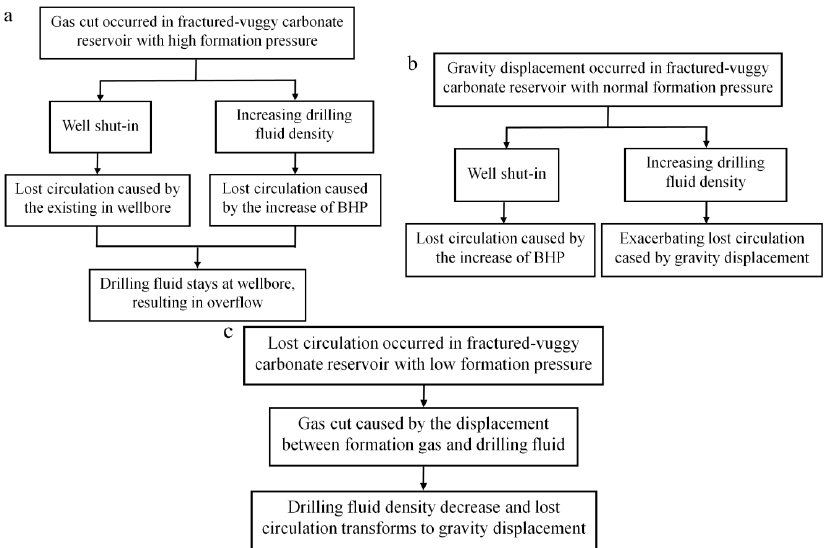
Figure 2. Complex bottomhole situations during drilling the fractured-vuggy carbonate reservoir with different formation pressures using non-delicate managed pressure drilling technology: ( a ) Fractured-vuggy carbonate reservoir with high formation pressure; ( b ) Fractured-vuggy carbonate reservoir with normal formation pressure; ( c ) Fractured-vuggy carbonate reservoir with low formation pressure.